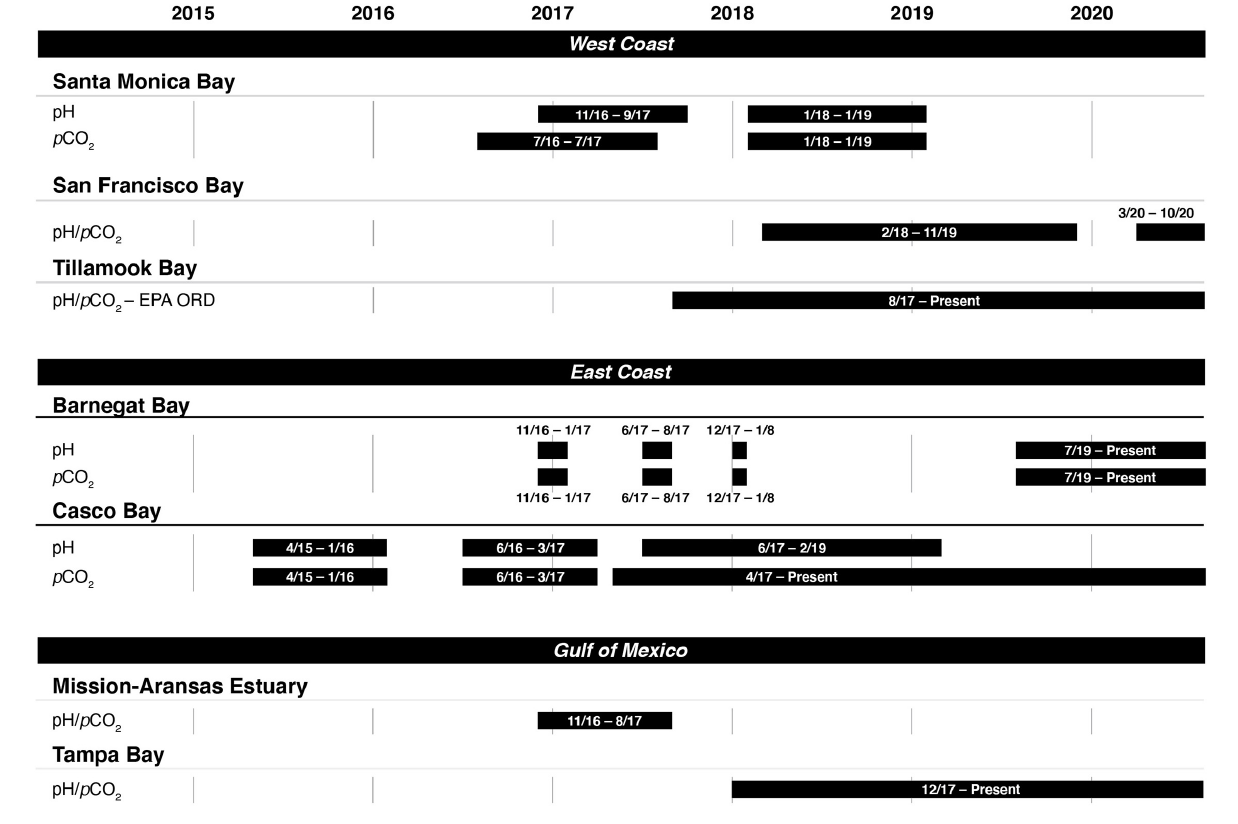
FIGURE 2 | Instrument deployment timelines for measuring pH and the partial pressure of carbon dioxide ( p CO 2 ) in seven of the United States Environmental Protection Agency’s (EPA’s) National Estuary Program